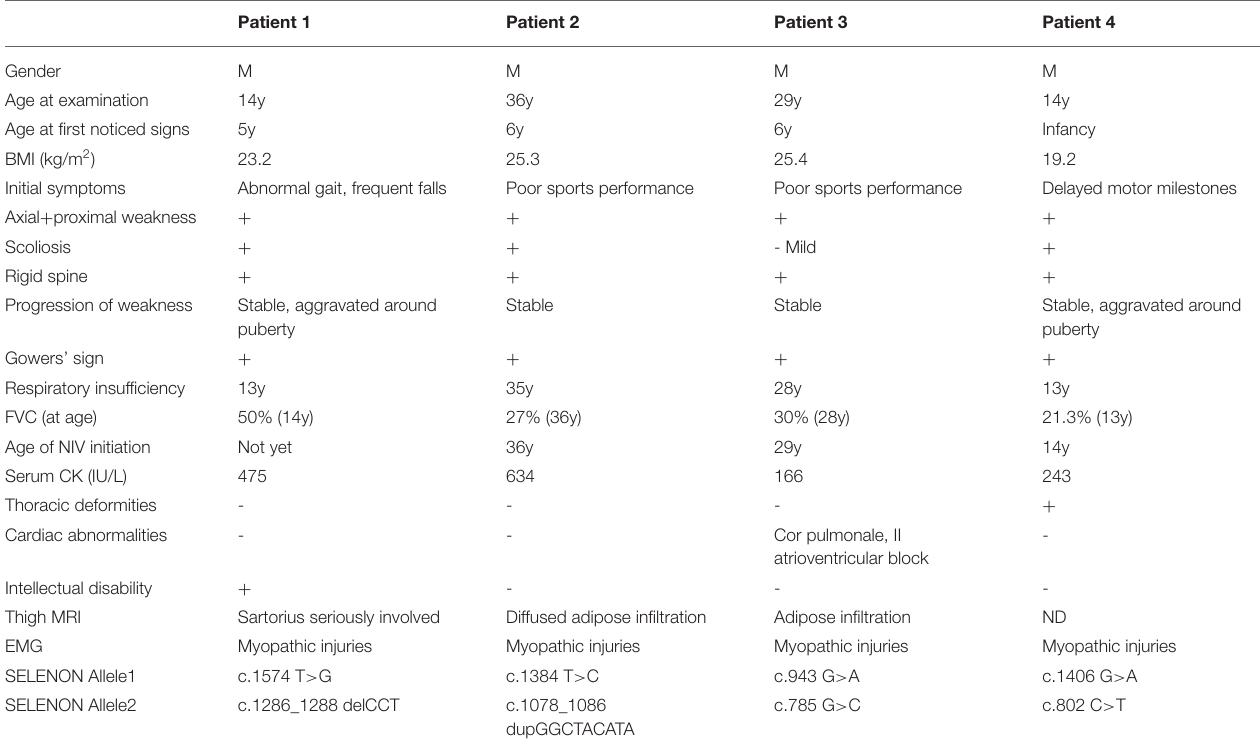
TABLE 1 | Detailed clinical features of four Chinese patients with